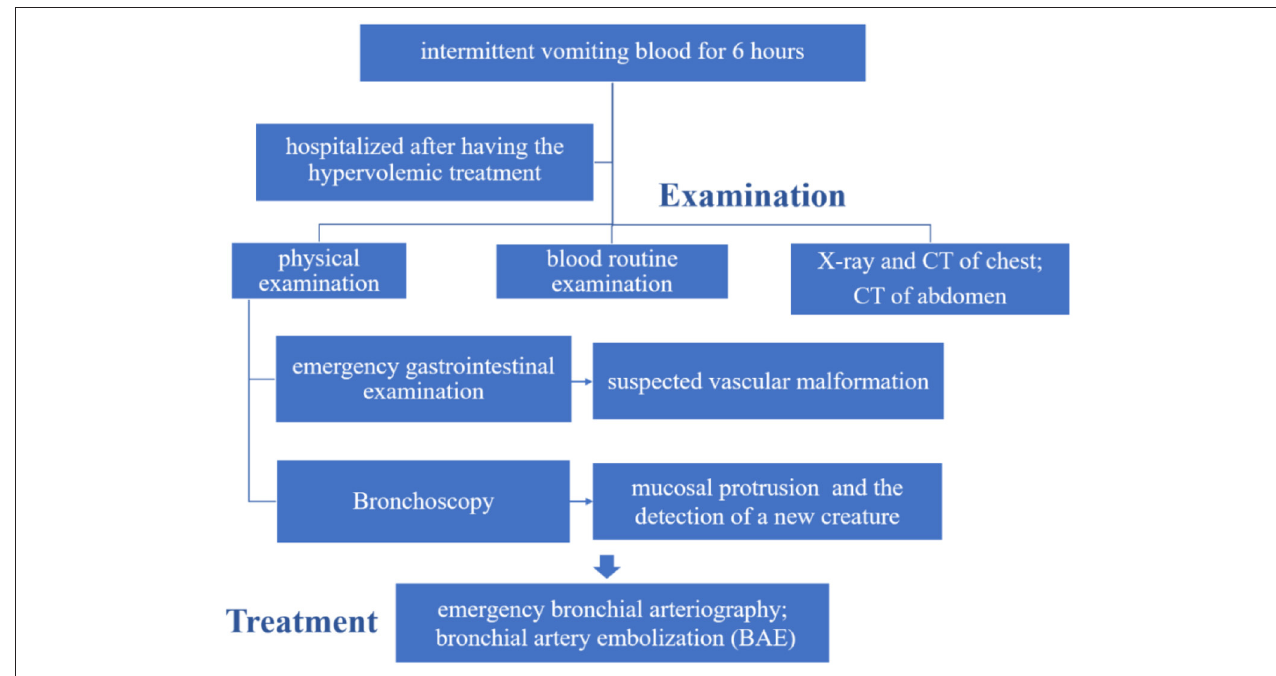
FIGURE 1 | Timeline of the treatment process of the